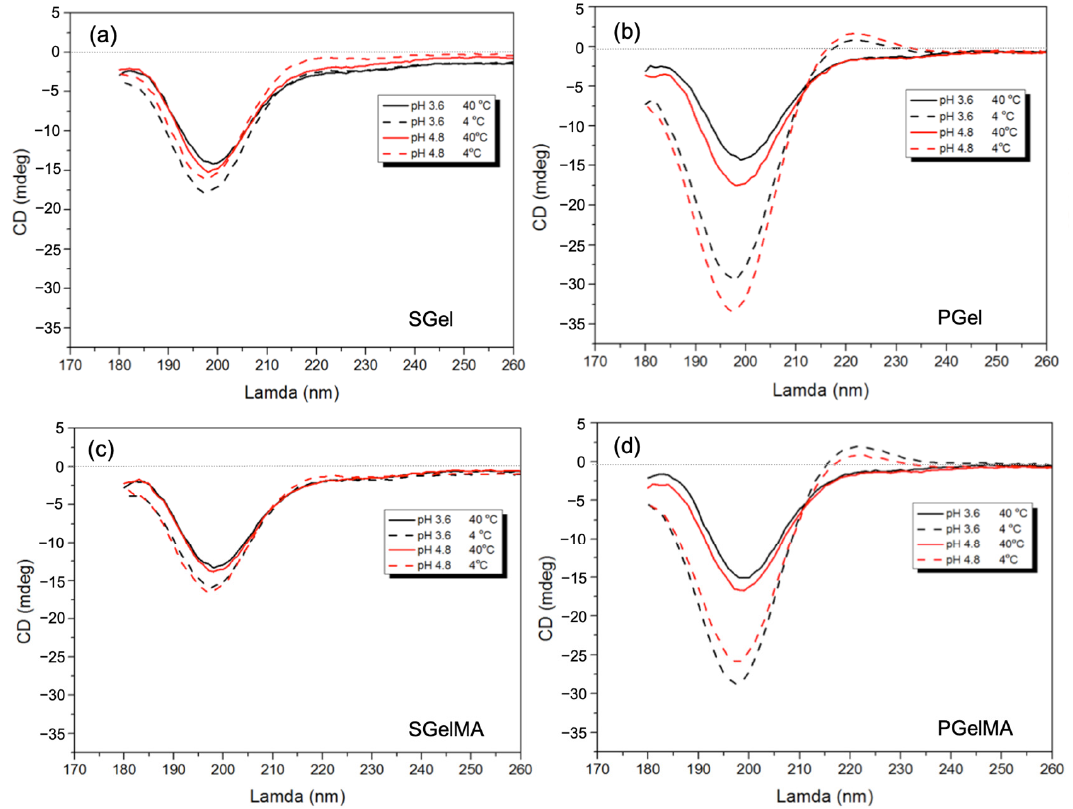
Figure 3. CD spectra assessed at temperatures above T gel (40 °C) and below T gel (4 °C) of SGel ( a ) and PGel ( b ) both at pH ~3.6 and 4.8 and their methacryloyl counterparts SGelMA ( c ) and PGelMA ( d ) both at pH ~3.6 and 4.8.